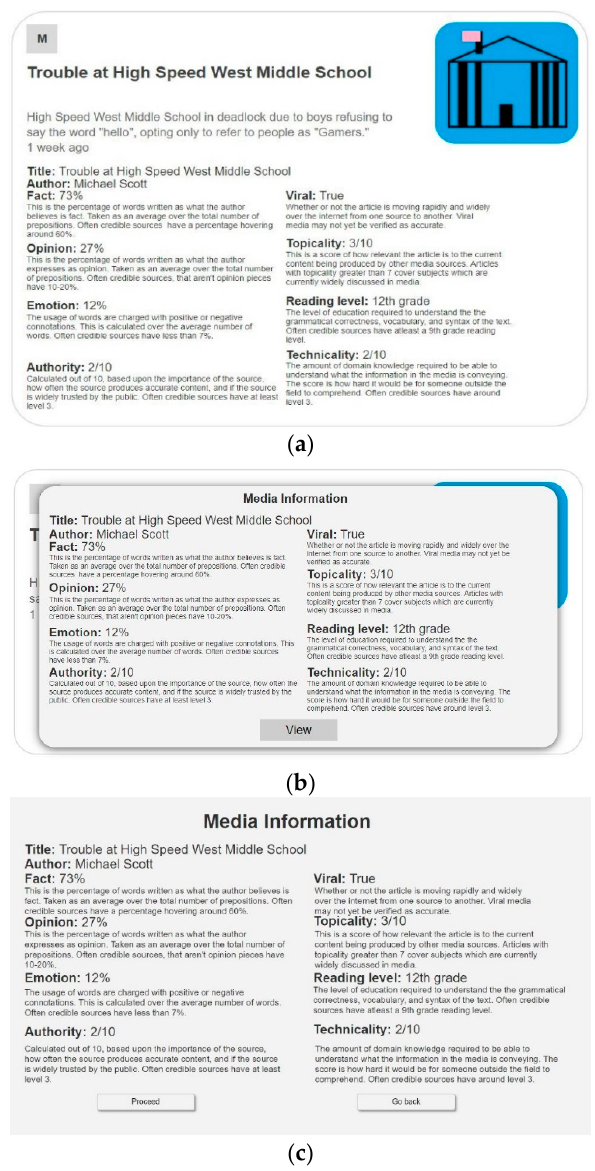
Figure 17. Examples of informational labels (using categories proposed by Fuhr et al. [49]): ( a ) Label 3—supplemental with context and extended explanation; ( b ) Label 4—replacement without context and with extended explanation; ( c ) Label 5—intermediary without context and with extended ex- planation.